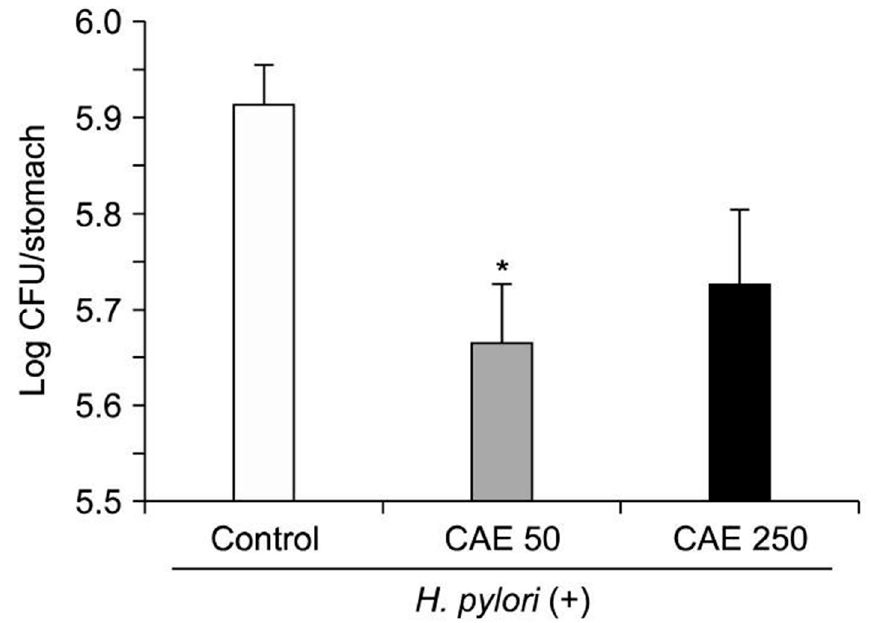
Figure 10. Effects of Centella asiatica leaf extract (CAE) against Helicobacter pylori colonization in C57BL/6 mice. CAE was administered orally at 50 and 250 mg/kg, once daily for three weeks. The results are expressed as mean ± SEM (n = 10). * p < 0.05 compared with the control. Figure and caption reused from Zheng et al. [82]. Used under the Creative Commons License (http://crea-